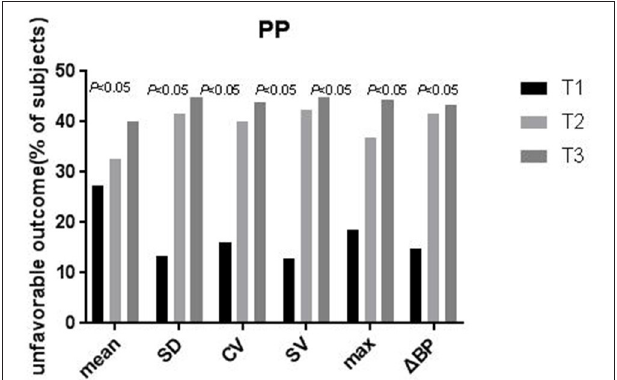
FIGURE 1 | Proportion of patients with unfavorable outcomes at 3-months according to tertiles of the pulse pressure variability parameters. The proportion of patients with unfavorable outcomes Increased significantly across the tertiles of SD, CV, SV, 1 BP, max, and mean ( P -values are for the X2 test for a linear trend, with the lowest tertile as the reference). PP, pulse pressure; SD, standard deviation; CV, coefficient of variation; SV, successive variation; 1 BP, maximum–minimum difference, max maximum, mean